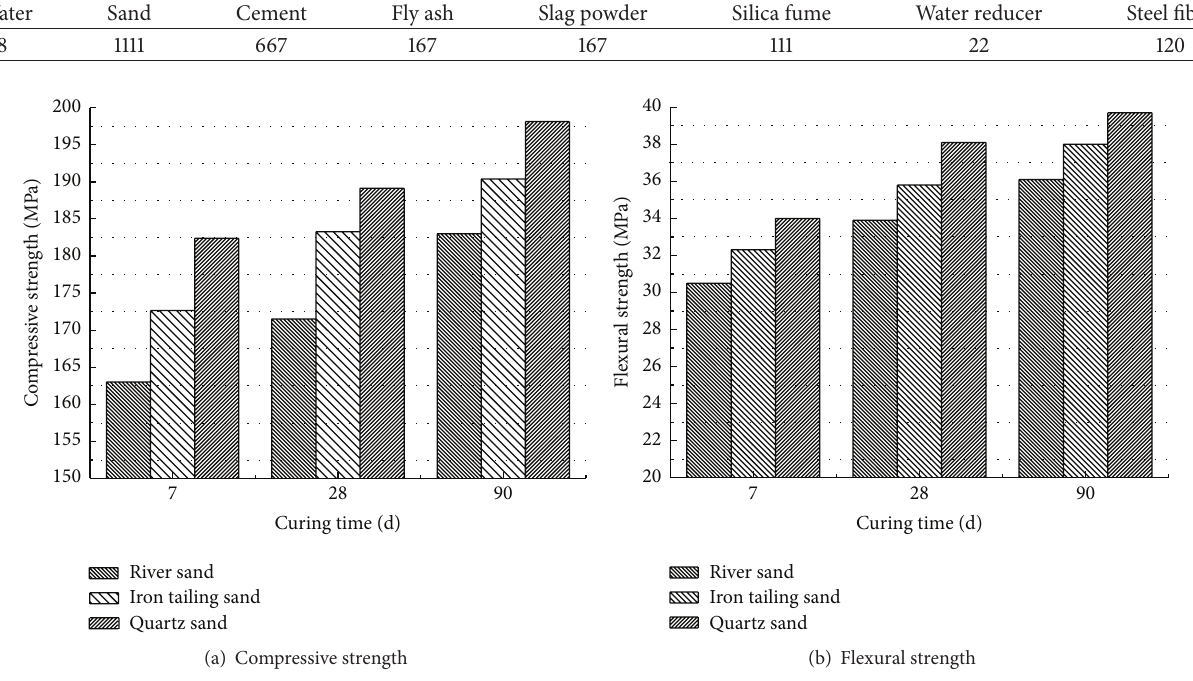
Table 3: The mix of UHPC (kg).